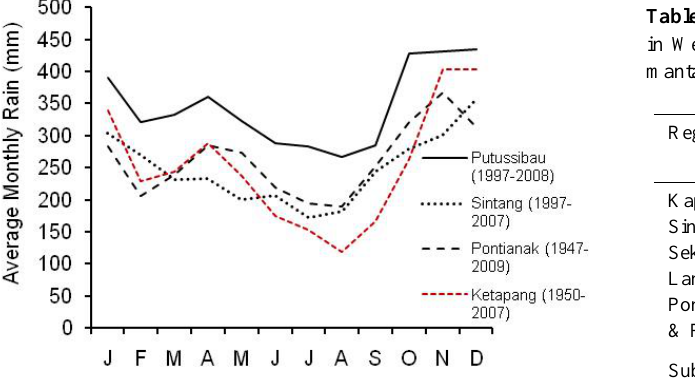
Fig. 1. The average monthly rain from selected climate stations in the West Kalimantan Province (Source: BMKG Supadio, unpublished, 2010).